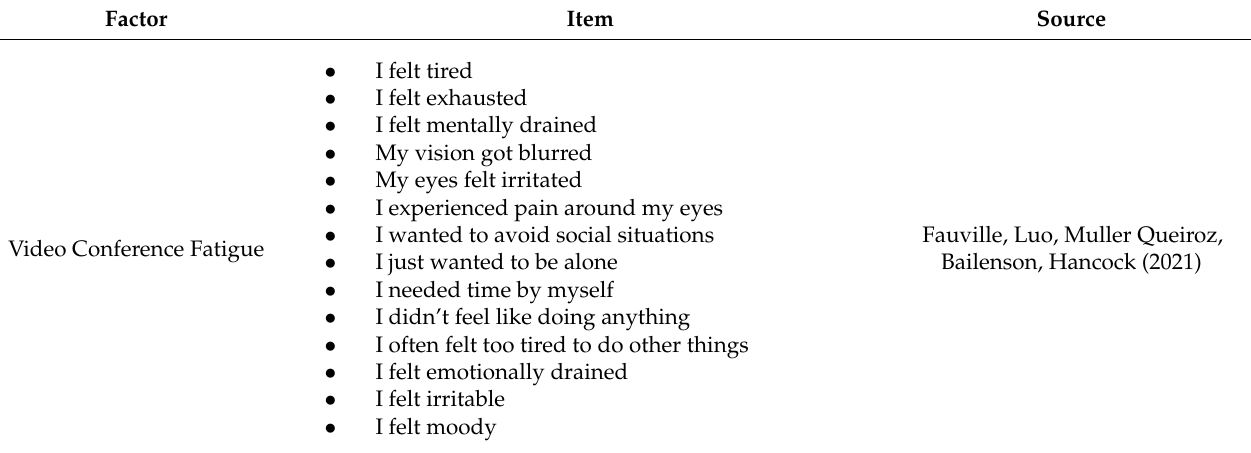
Table 3. Video conference